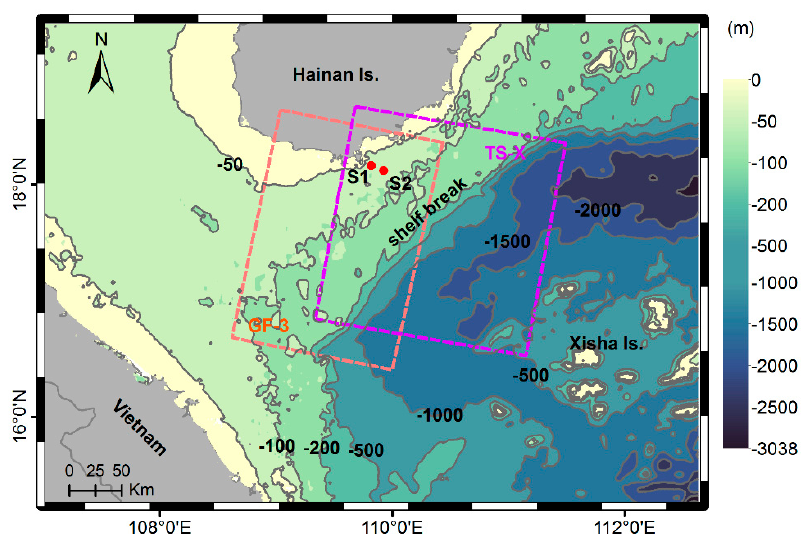
Figure 1. Bathymetric map of southeastern Hainan Island and its adjacent area. The synthetic aperture radar (SAR) image coverages are indicated in the orange dashed line box (GF-3) and the purple box (TS-X). The two locations S1 and S2 where conductivity–temperature–pressure (CTD) measurements were taken are marked by red dots.